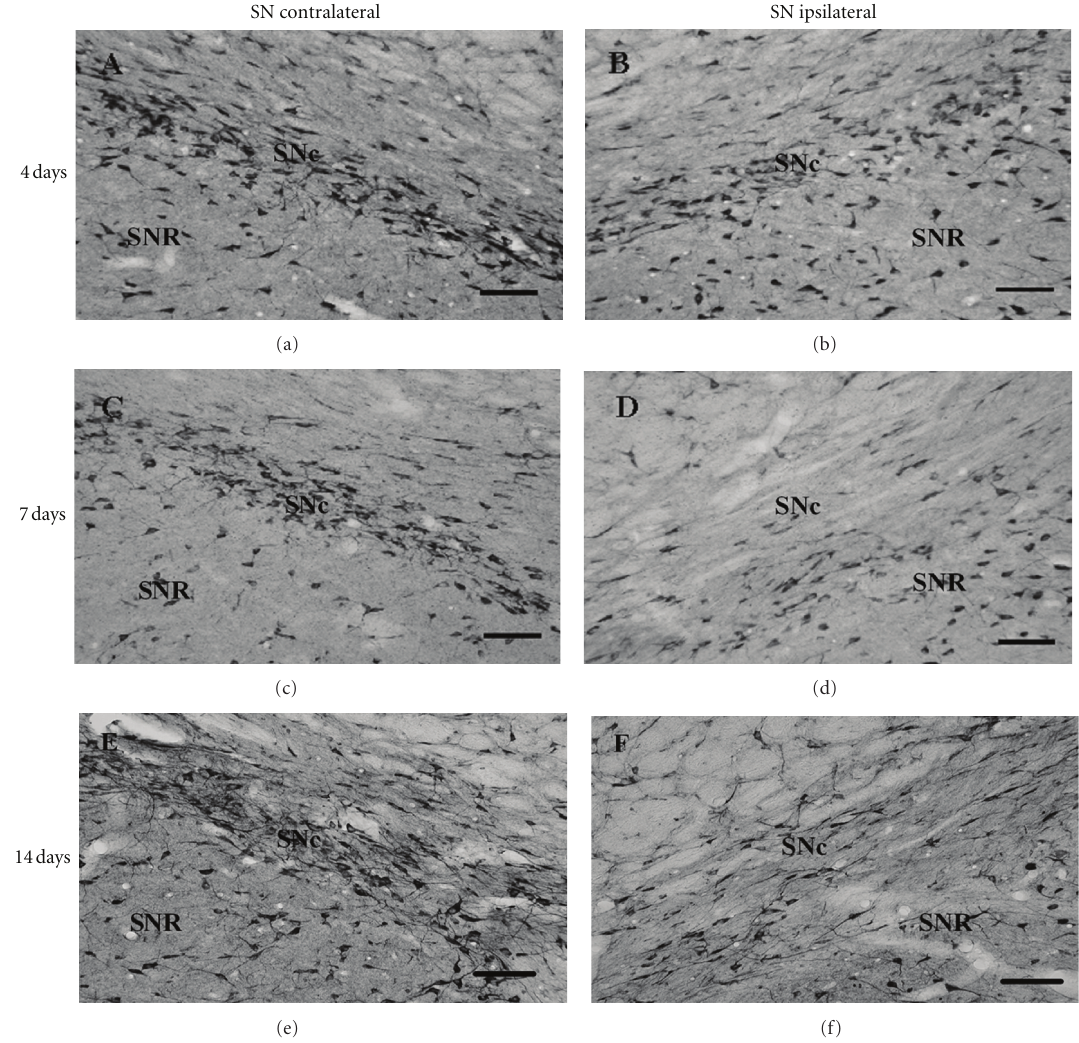
Figure 2: Photomicrographs showing a decrease in the number of trkB-IR cells in ipsilateral SNc at 7 and 14 days, but not at 4 days, after unilateral 6-OHDA intrastriatal injections. Photomicrographs show trkB-immunoreactive (IR) cells in the contralateral (a), (c), and (e) and ipsilateral (b), (d), and (f) sides of rat SN at 4, 7, and 14 days after unilateral intrastriatal injection of 6-OHDA. (a)–(f) scale bar = 100 mm. SNc: substantia nigra pars compacta; SNR: substantia nigra pars